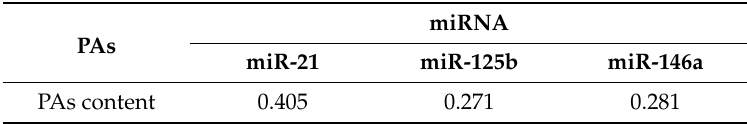
Table 4. Pearson’s correlation coefficients ( r ) between PAs contents and inhibition rates of miR-21, miR-125b, and miR-146a of the 16 blueberry samples. miRNA PAs miR-21 miR-125b miR-146a PAs content 0.405 0.271